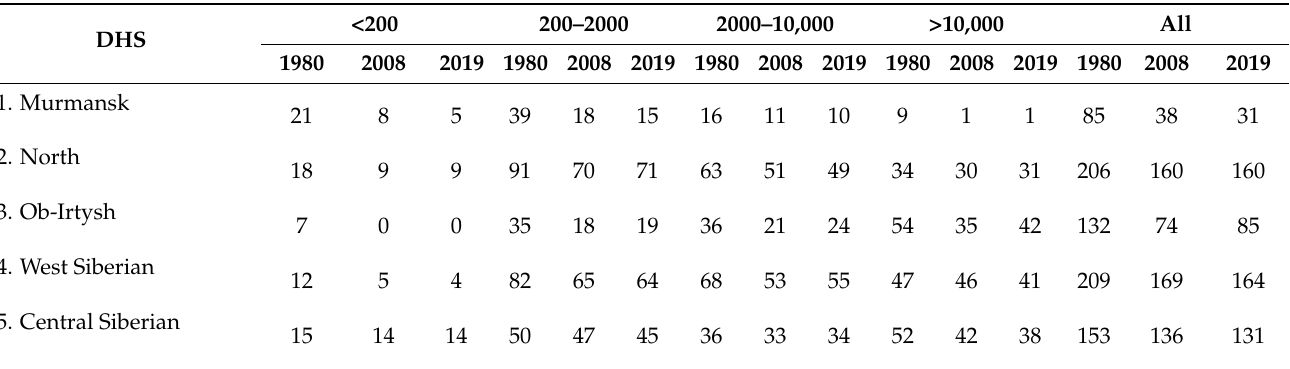
Table 2. The number of hydrological gauges where streamflow discharge is measured, classified by basin